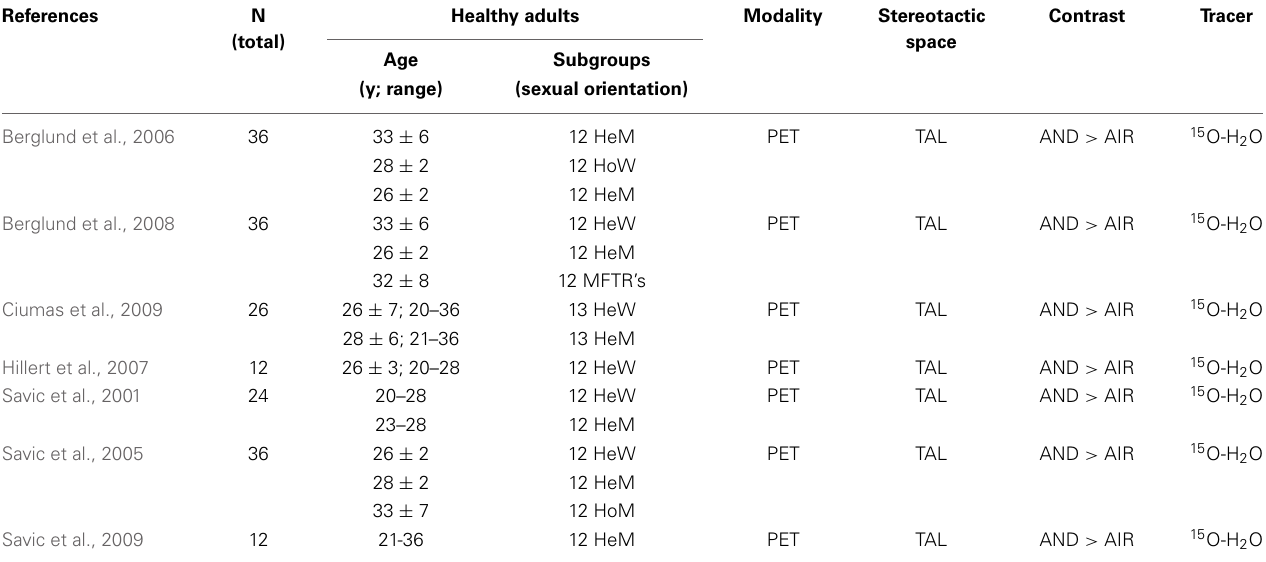
Table 2 | Overview of studies included in graphic